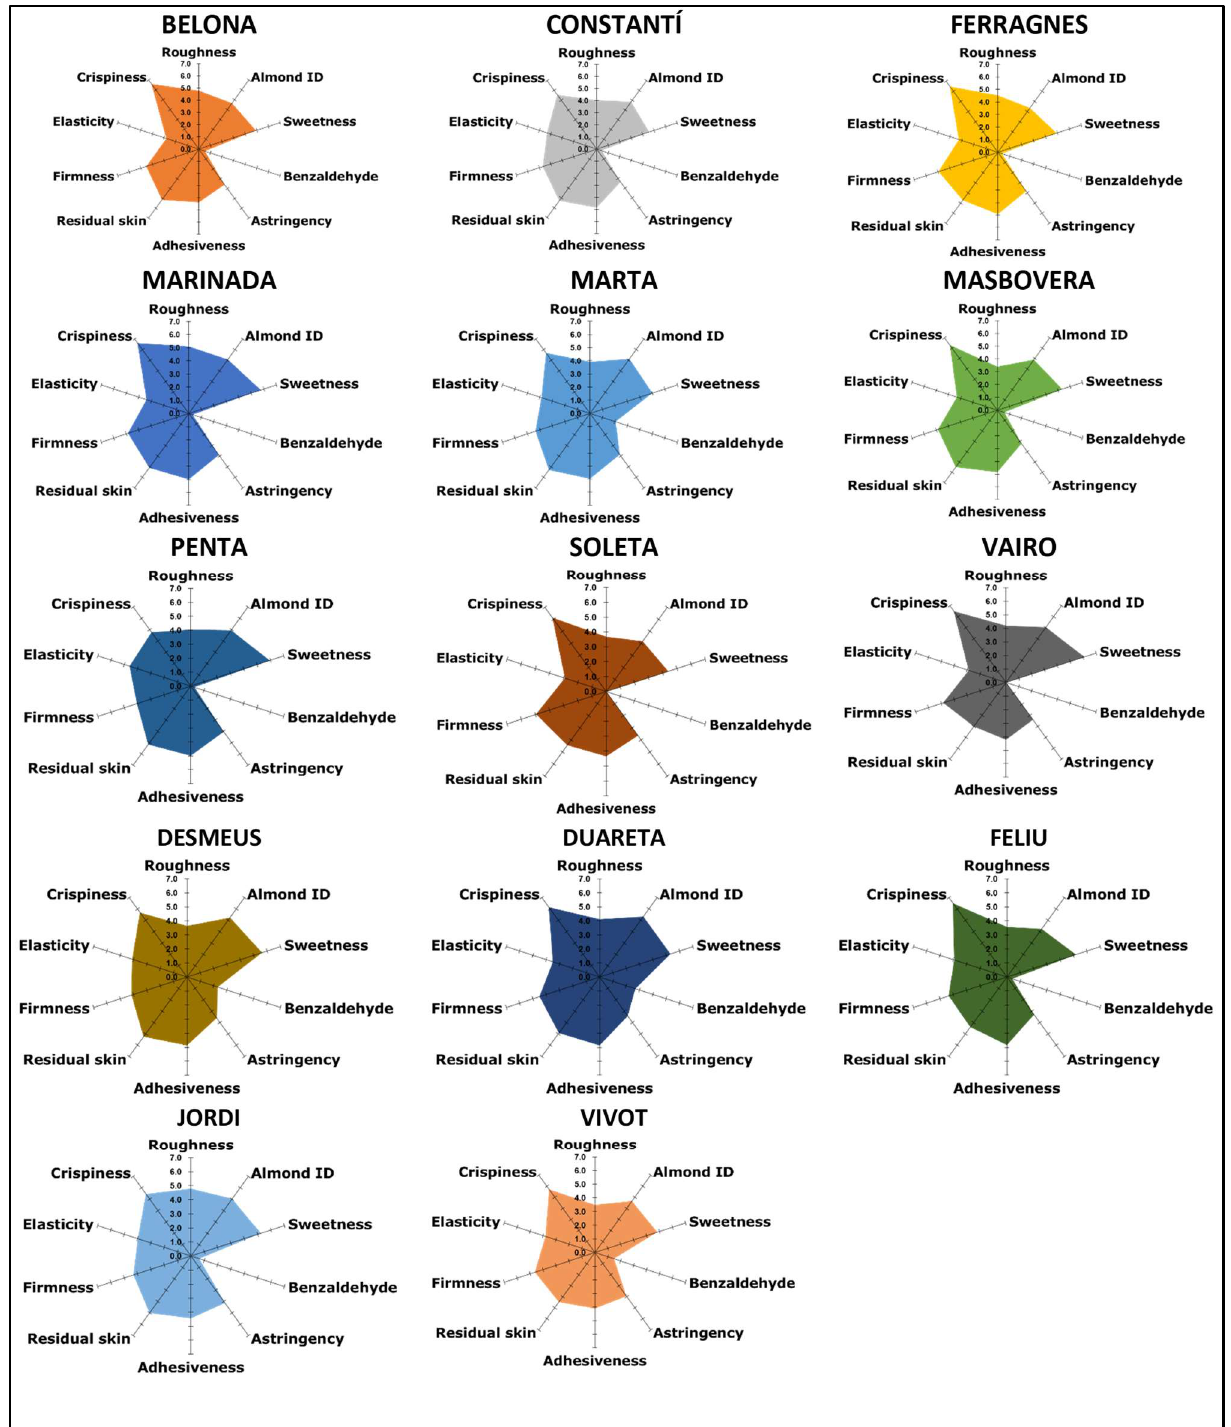
Figure 4. Sensory profile of each almond cultivar.